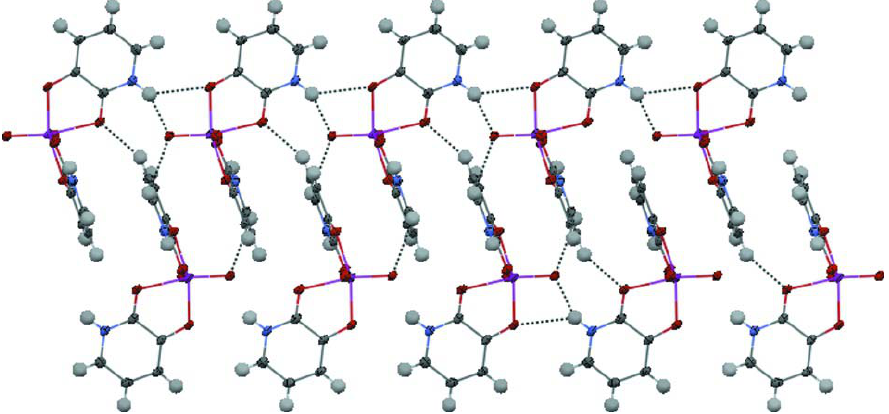
Figure 1 The molecular structure with displacement ellipsoids drawn at the 50% probability level for non-H atoms